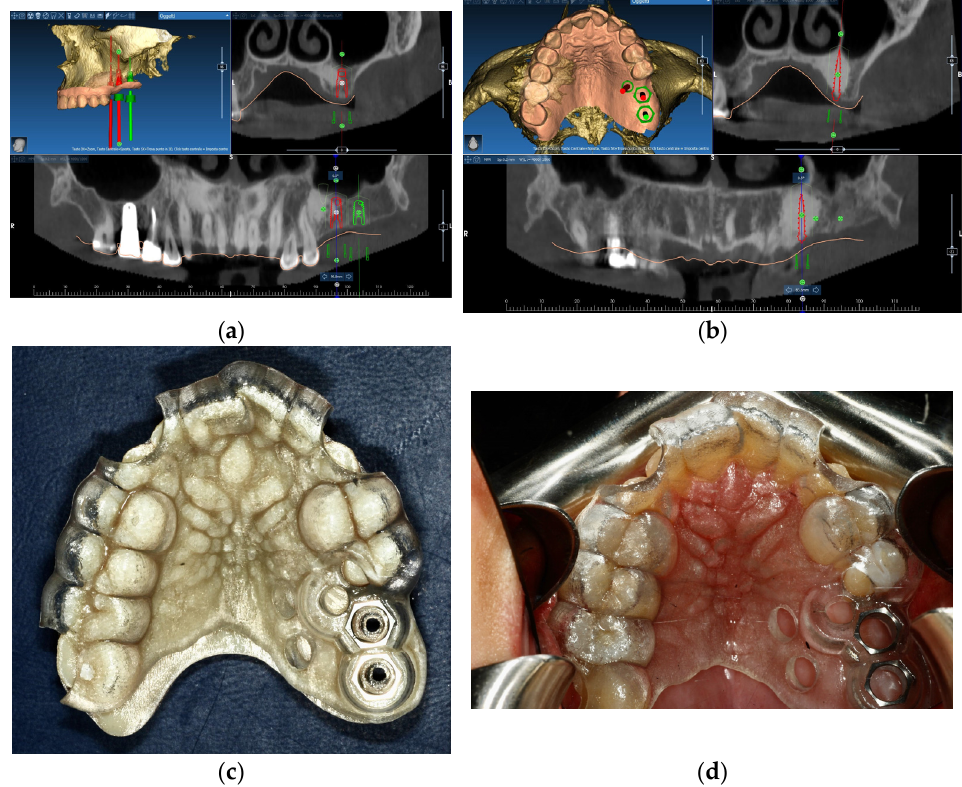
Figure 4. Surgical drill guide: ( a ) implant placement planning; ( b ) osteotomy planning; ( c ) occlusal view of the guide on the model; ( d ) occlusal view of the guide on the patient. The oral implants Zimmer 4.1 × 10 TSVM4B10 and Zimmer 4.1 × 8 TSVM4B8